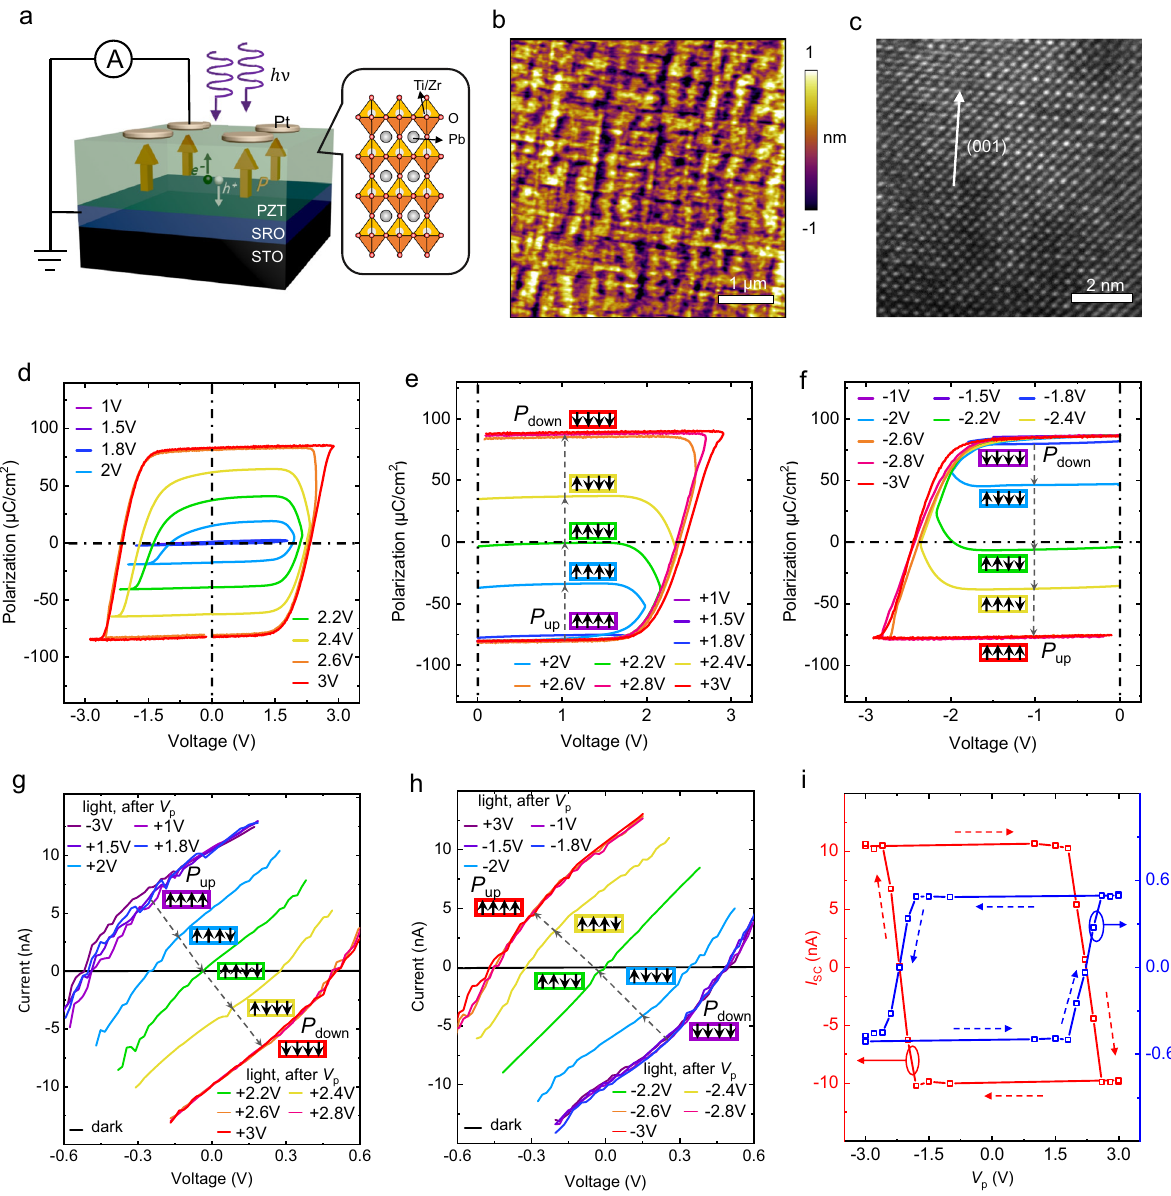
Fig. 2 Polarization switching behavior and polarization-tuned multilevel nonvolatile photovoltaic responses in FE-PS. a Schematics illustrating the device structure of the Pt/ PZT (epitaxial fi lm)/SRO FE-PS (left panel) and the crystal structure of PZT (right panel). b AFM topography image and c high- resolution cross-sectional TEM image of the epitaxial PZT fi lm. d Bipolar, e positive monopolar, and f negative monopolar P – V hysteresis loops measured with different pulse voltages. Illuminated I – V characteristics measured after applying different g positive pulses and h negative pulses to the FE-PS initialized by − 3 V and + 3 V pulses (pulse width: 0.15 ms), respectively. In e – h , the different polarizations states are schematically illustrated by the con fi gurations of the four black solid arrows. i I sc and V oc as a function of the write pulse voltage ( V p